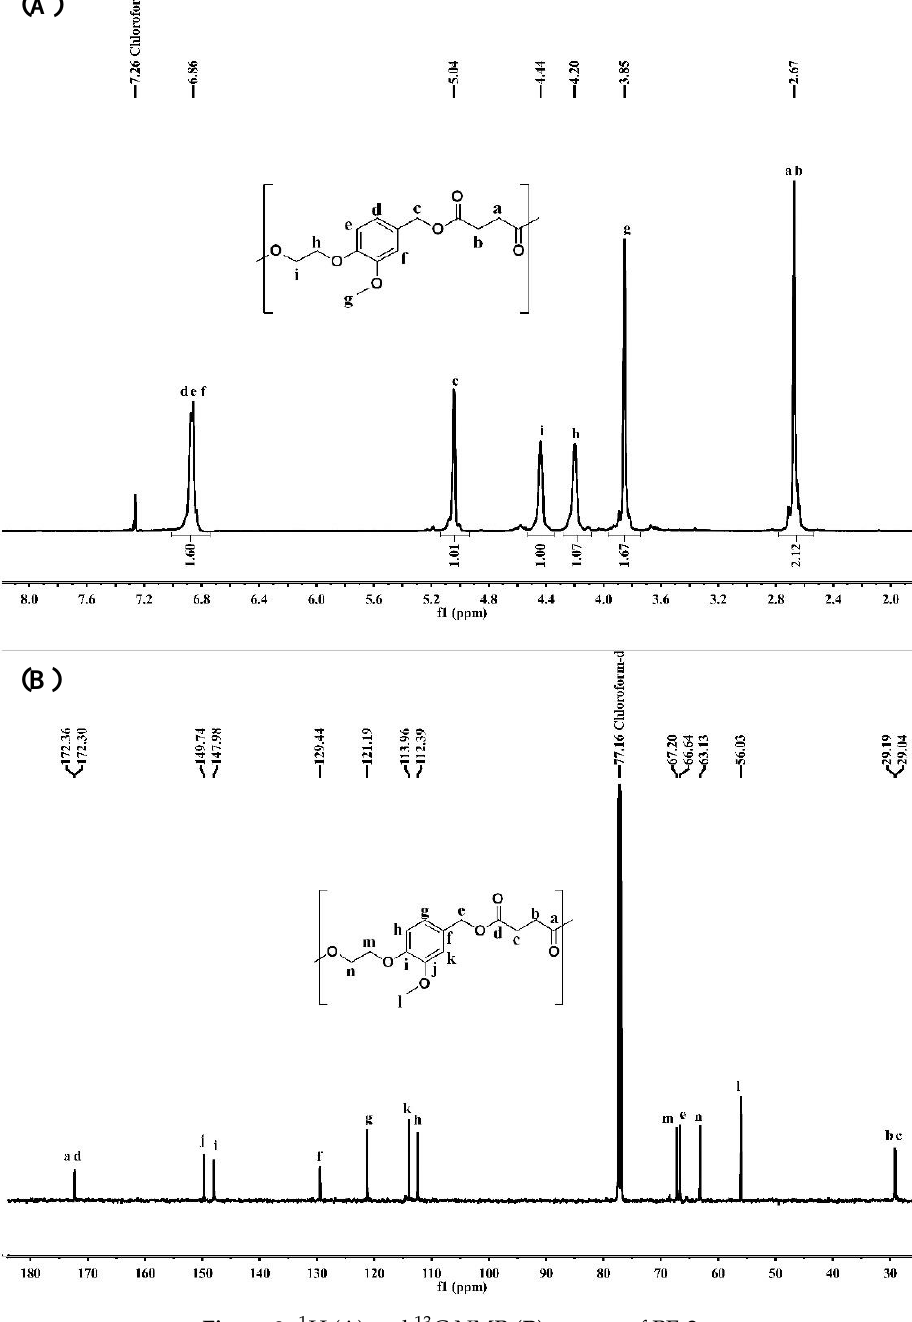
Figure 2. 1 H ( A ) and 13 C NMR ( B ) spectra of PE-2.